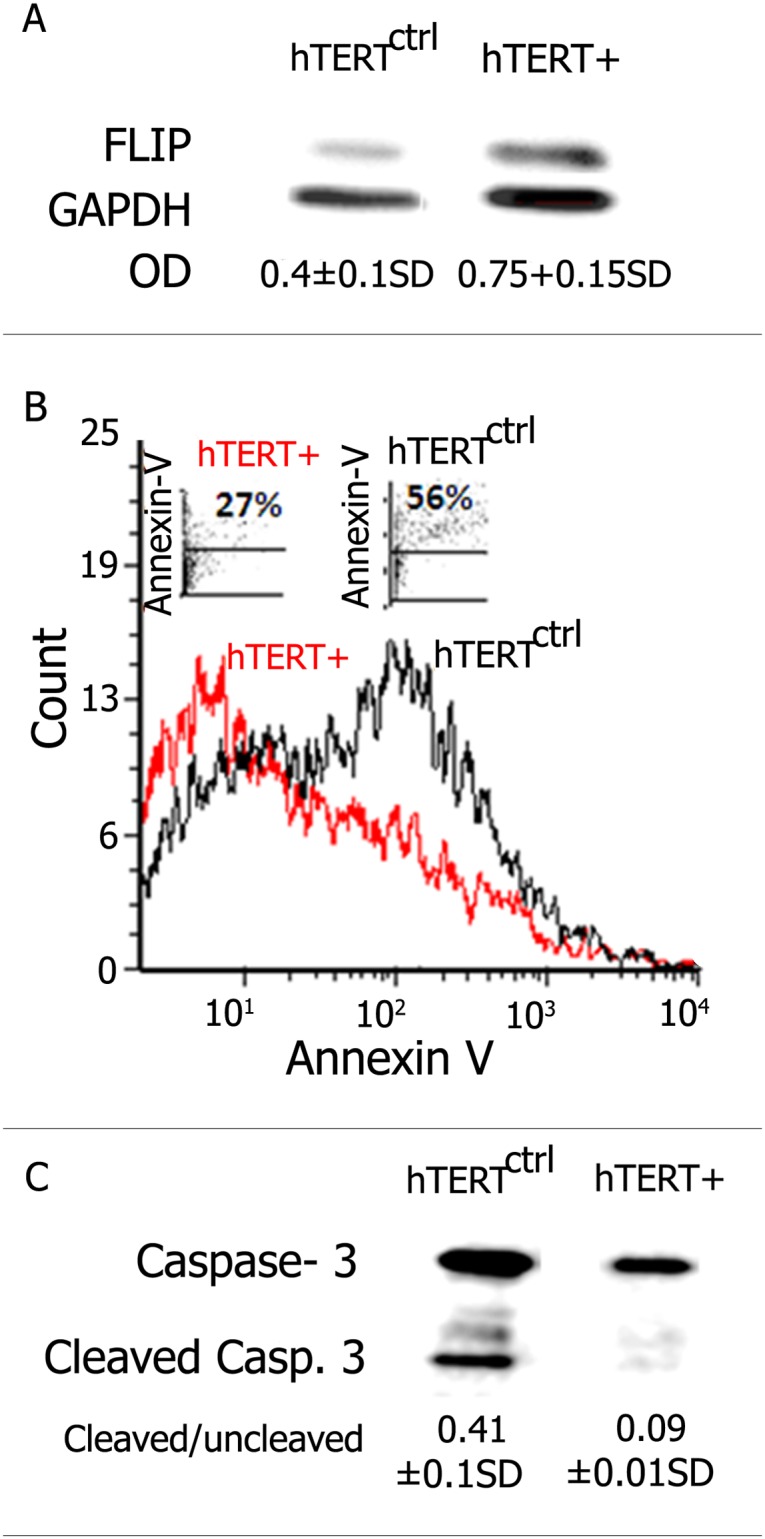
hTERT+-transfected human lung epithelial A549 cells upregulate FLIP levels and acquire resistance to Fas induced apoptosis.(A) Western blot of FLIP expression using anti-FLIP mAb in hTERTctrl (control) vs. hTERT+ transfected cells from a human lung epithelial cell line (A549). Optical densities showing increased FLIP in hTERT+ human lung A549 epithelial transfected cells are presented (OD). (B) Histogram plots of flow cytometry analysis showing decreased Annexin V staining in hTERT+ (red) when compared to hTERTctrl (black) transfected cells (A549). (C) Western blot showing decreased caspase 3 cleavage in hTERT+, when compared to the hTERTctrl transfected A549 cell line. Cleaved/uncleaved caspase 3 OD ratios are presented. Representative results of two different experiments for each assay, with similar results.